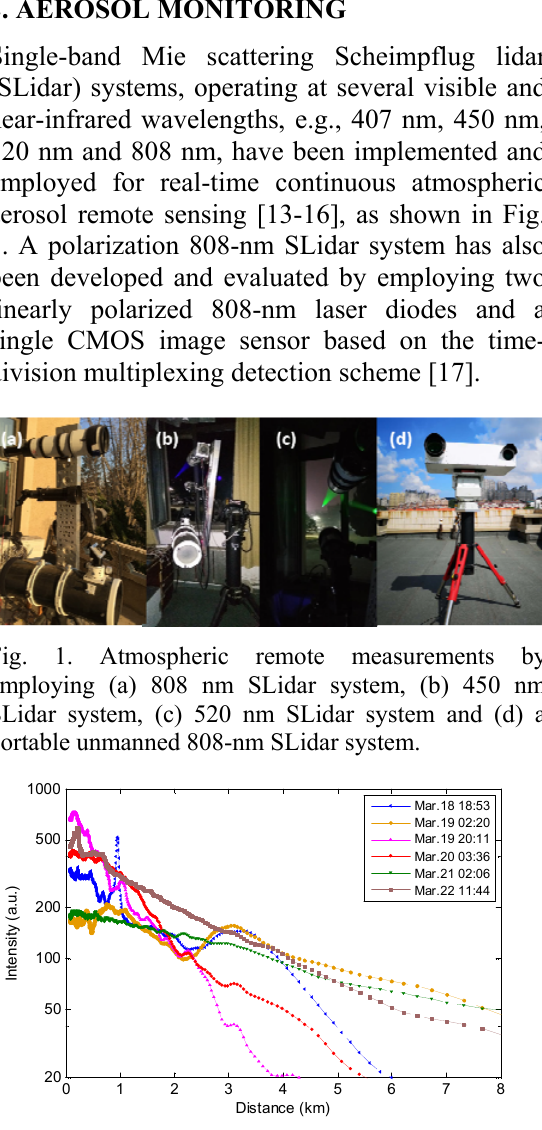
Fig. 2 Atmospheric backscattering signal measured on a near horizontal path by employing an 808-nm SLidar system in